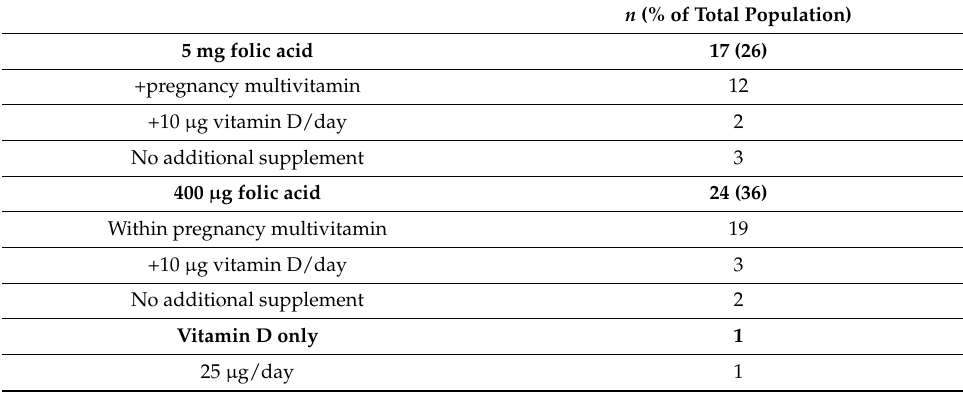
Table 3. Breakdown of supplements consumed by women in trimester